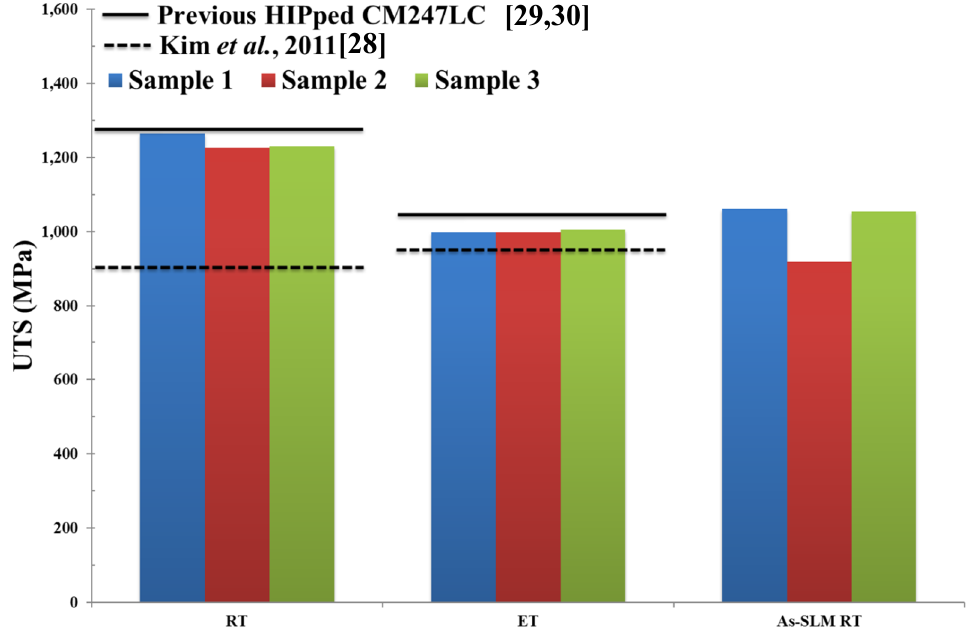
Figure 19. Bar plot showing Ultimate Tensile Strength (UTS) of HIPped CM247LC at Room Temperature (RT) and Elevated Temperature (ET), as well as SLM-processed CM247LC at RT for comparison [1]. Properties for conventionally cast and heat treated CM247LC are represented by the dashed line [28] and previous results of HIPped CM247LC undertaken in AMPLab by the solid line [29,30].